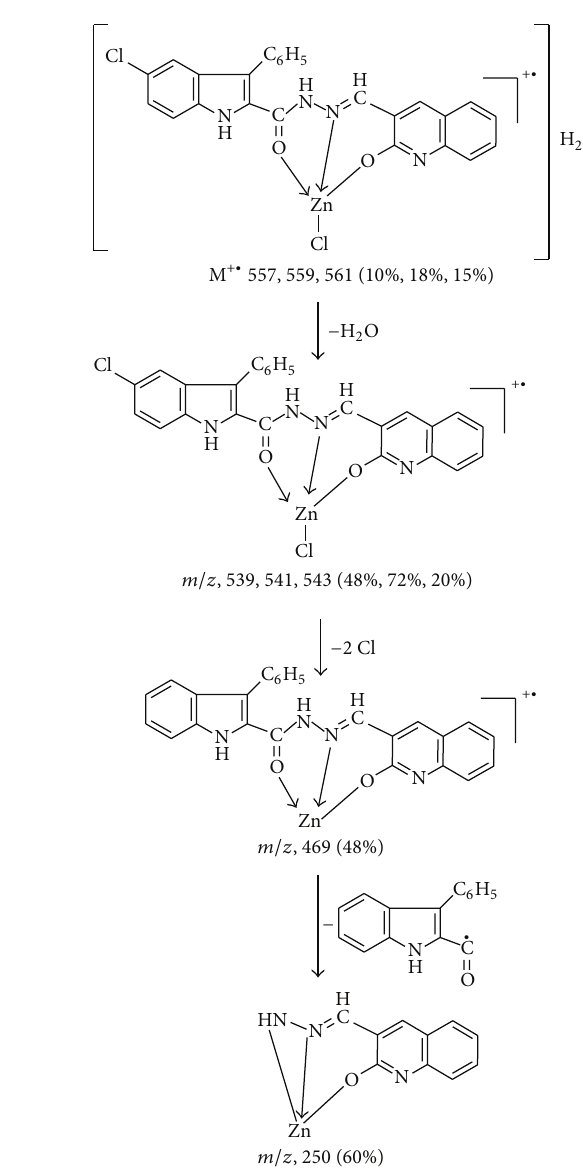
Scheme 3: Mass fragmentation of Zn(II)